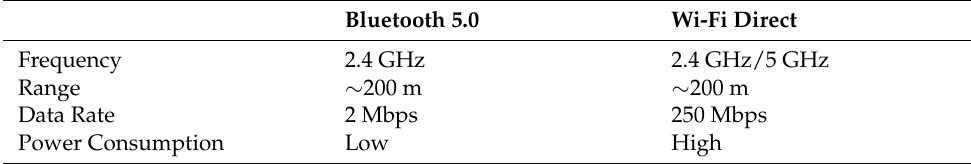
Figure 1. Device discovery in the find phase of Wi-Fi Direct protocol. Table 1. Comparison of Bluetooth 5.0 and Wi-Fi